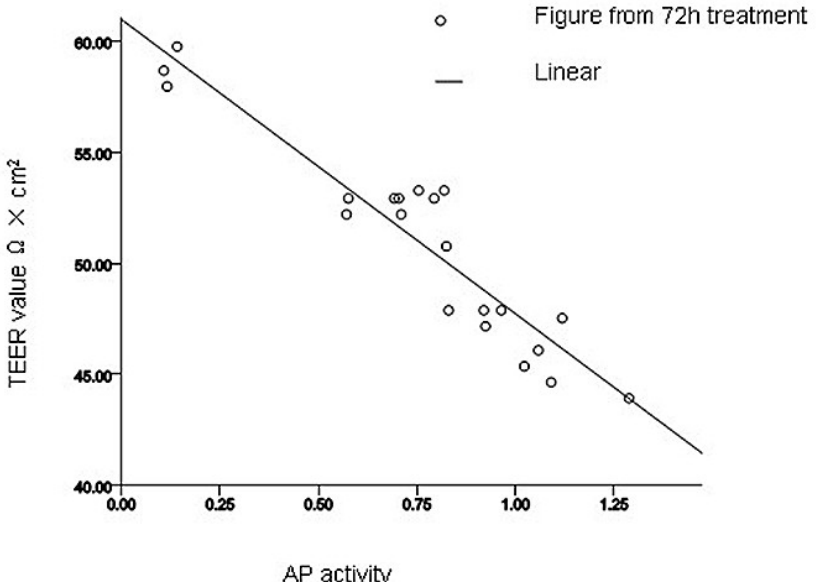
Figure 3. Linear correlations between AP activity and TEER value after 72 h treatment with 0, 0.5, 1.0, 1.5, 2.0, 2.5, or 3.0 mg/mL SBA. The formula was obtained by SPSS 17.0 software (SPSS Inc, Chicago, IL, USA. n R 2 = 0.883, R 2 = 0.883, p < 0.01, TEER values were dependent variable, AP activity were independent